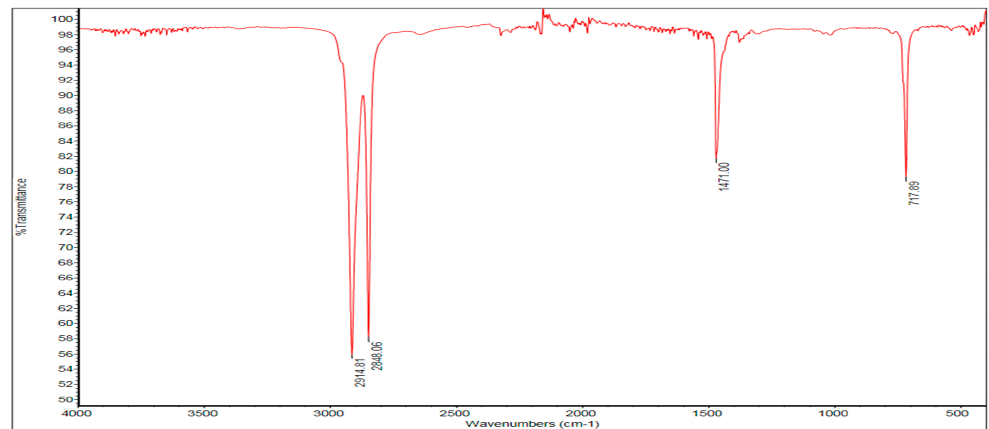
Figure 9. FTIR analysis of LLDPE blank sample at day 7 (with thermal treatment).